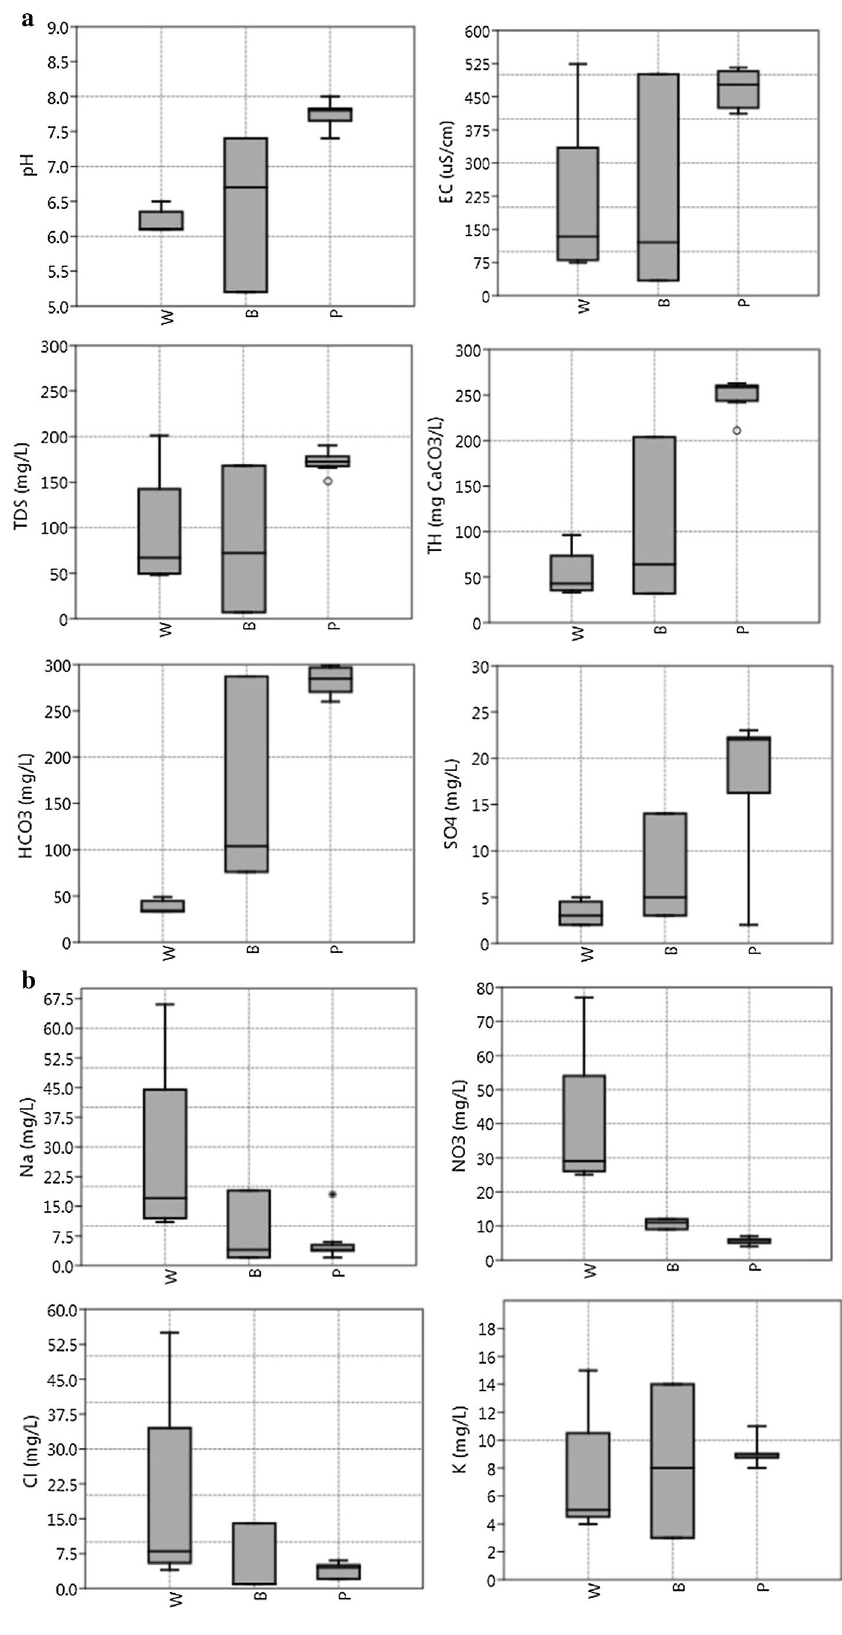
Fig. 3 a Boxplots of naturally affected physicochemical parameters in the Upper Pre- cambrian sedimentary aquifer of the northwestern Burkina Faso. The tops and bottoms of the boxes represent the 75th and 25th percentiles, respectively. The horizontal line across the boxes indicates the median. The vertical lines from the tops and bottoms of the boxes extend to 90th and 10th percentiles, respectively. b Boxplots of anthropogenically affected phys- icochemical parameters in the Upper Precambrian sedimentary aquifer of the northwestern Burkina